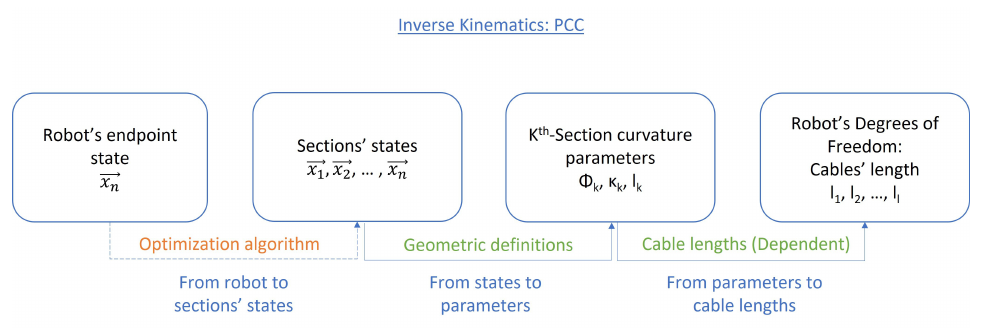
Figure 12. Inverse kinematics for